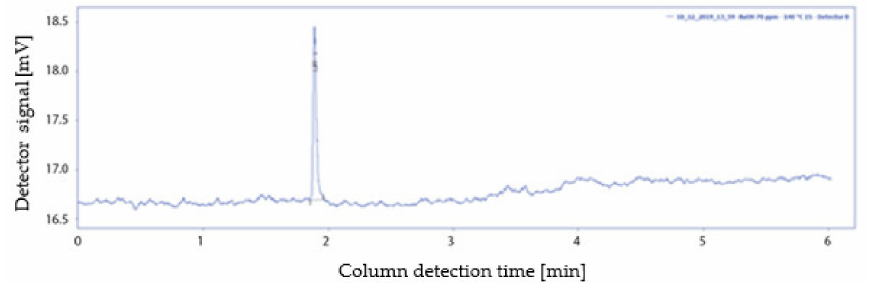
Figure 4. Chromatogram obtained from one of the samples generated with a vaporisation tempera- ture equal to 140 ◦ C; visible pack at 1.89 min is related to butanol and is verified using a traceable gas